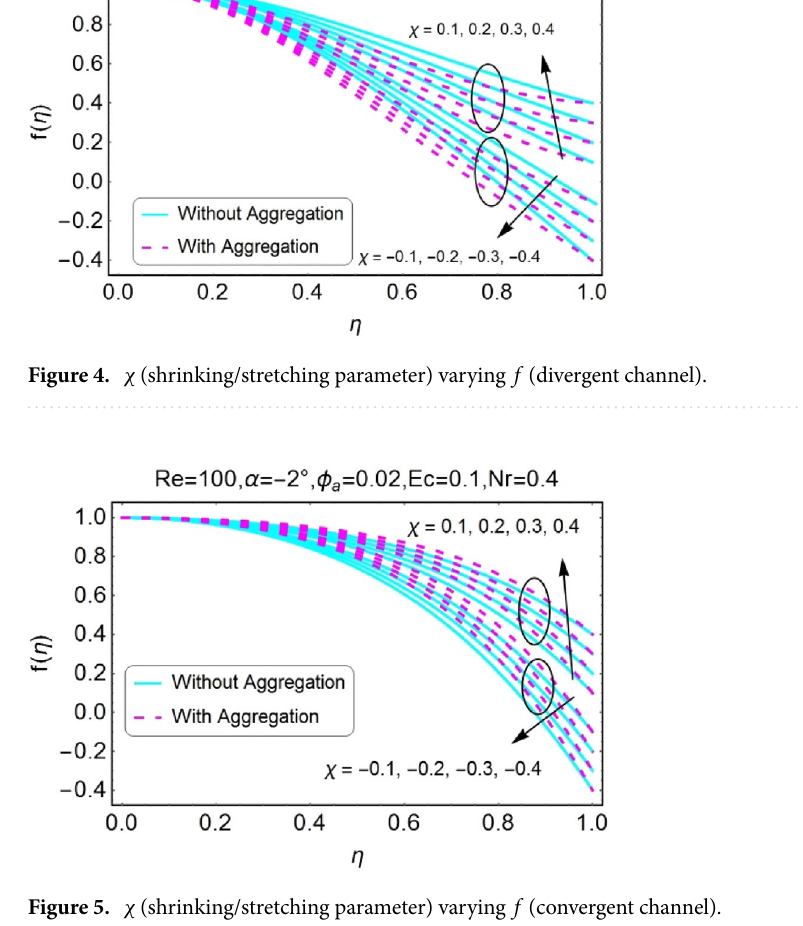
Figure 5. χ (shrinking/stretching parameter) varying f (convergent channel).